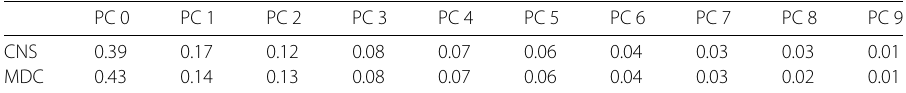
Table 6 Variance explained by principal components. The fraction of variance explained by each principal component for the CNS and MDC